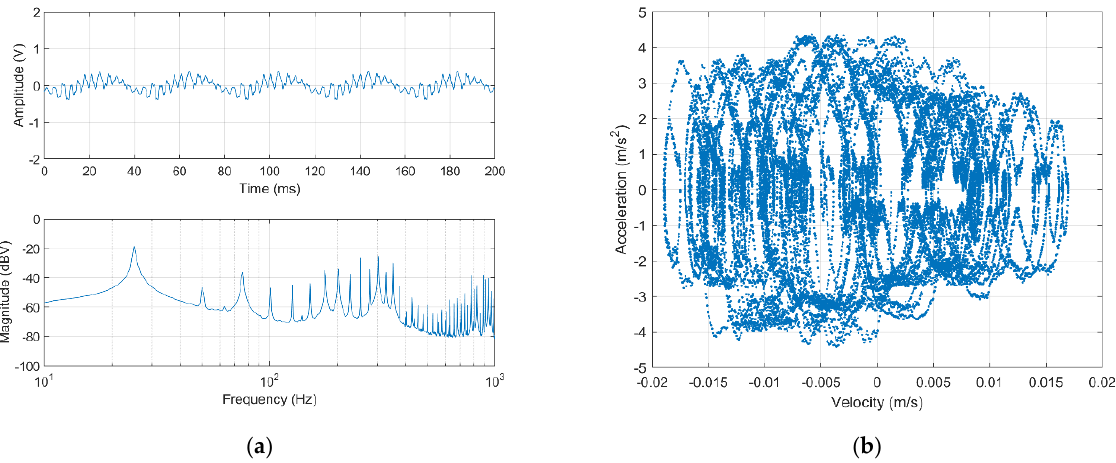
Figure 7. PEH is excited by a sinusoidal wave with an amplitude of 5 V and frequency of 25.4 Hz: ( a ) voltage-time response and its Fourier transform; ( b ) experimentally measured phase portrait.